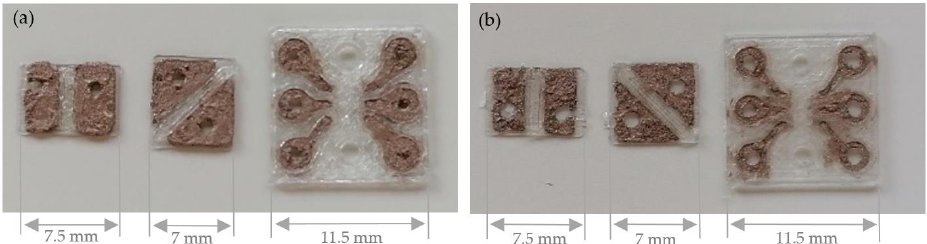
Figure 17. 3D printed LED and RGB sequins at 95% material flow with the conductive filament